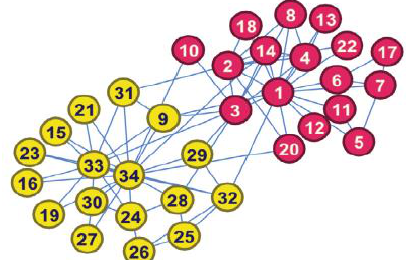
Figure 1. Zachary Club Karate